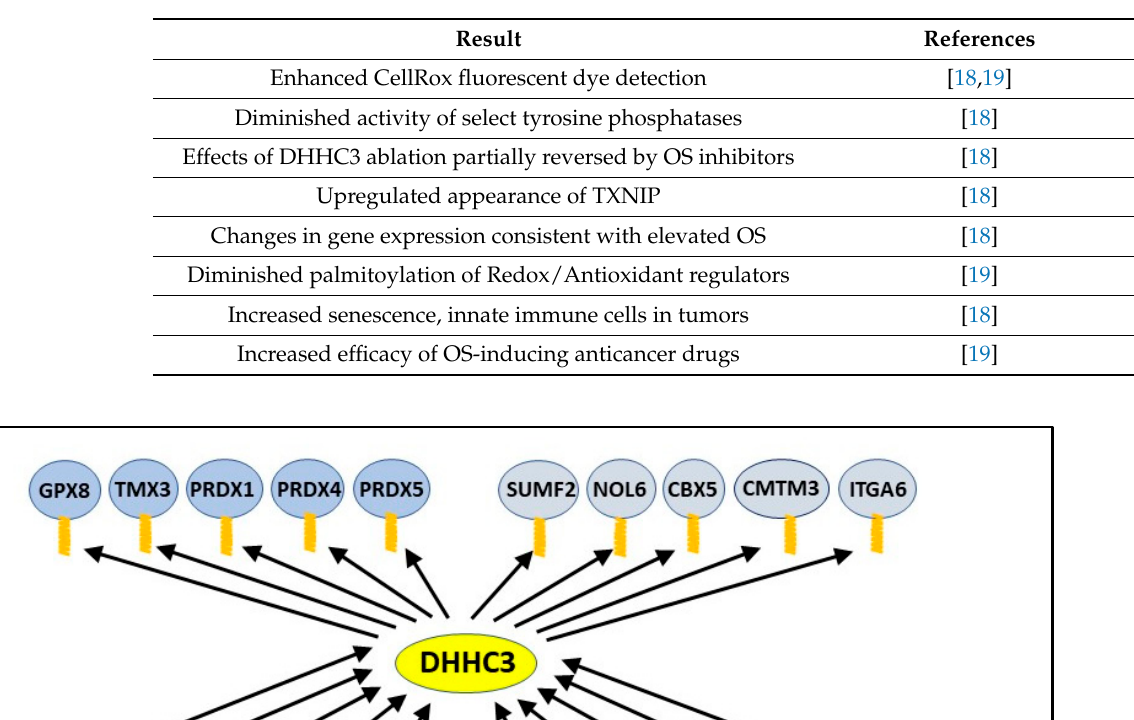
Table 1. Consequences of DHHC3 ablation consistent with elevated OS.